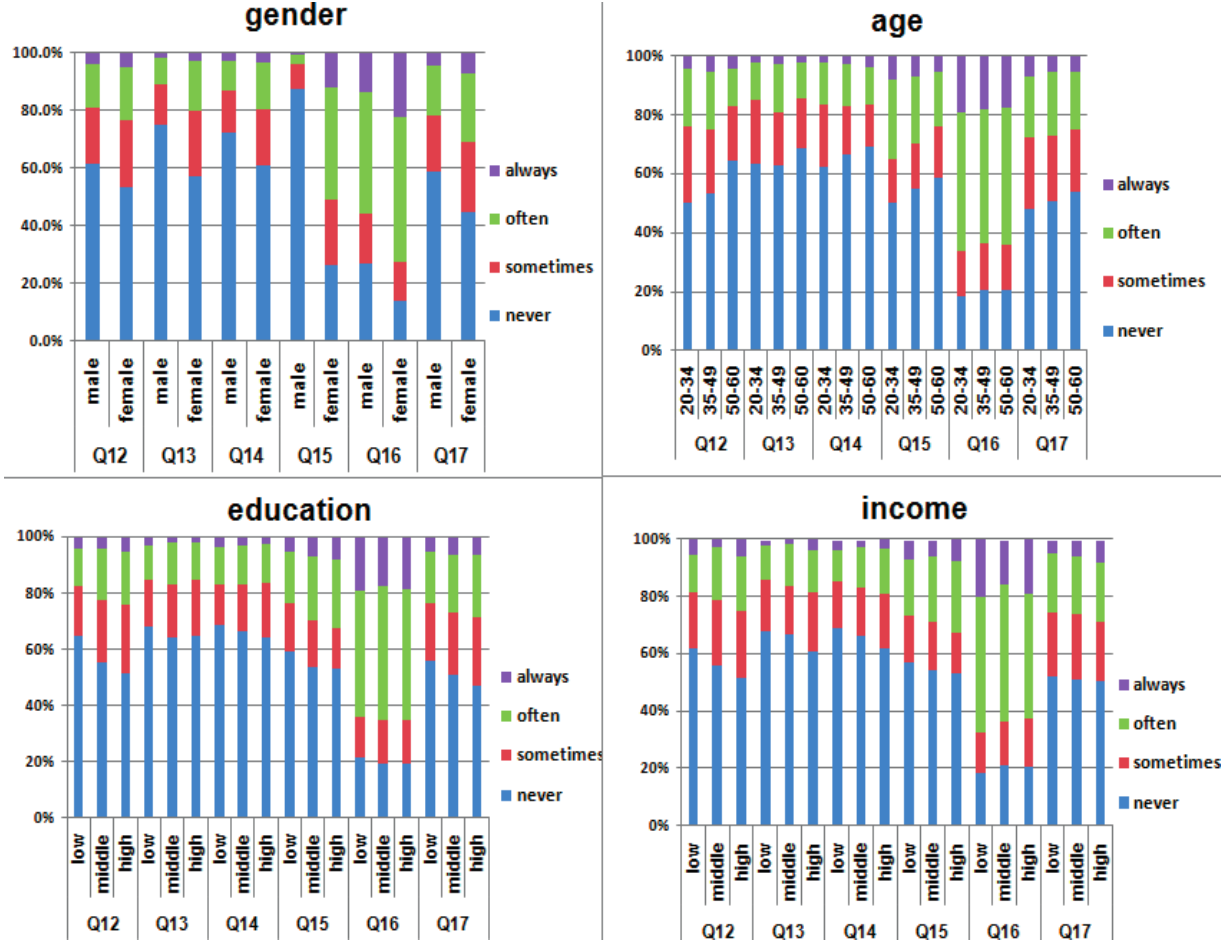
Figure 1. Different ways used by participants to protect them from sun, which were stratified by age, sex, education level and income. Q12: wear sunglasses; Q13: wear long pants and long-sleeved shirt to avoid sunburn; Q14: wear hats; Q15: use umbrella; Q16: seek shade while outside; Q17: consider the texture of sun-protective